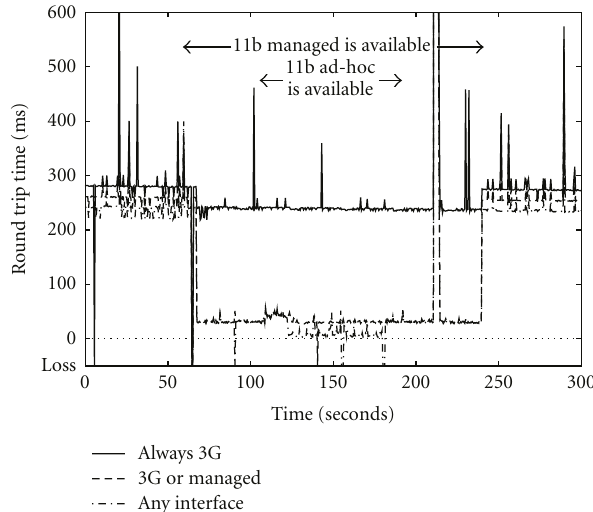
Figure 13: Impact of route changes on the RTT, measured using ICMPv6 packets in the absence of background tra ffi